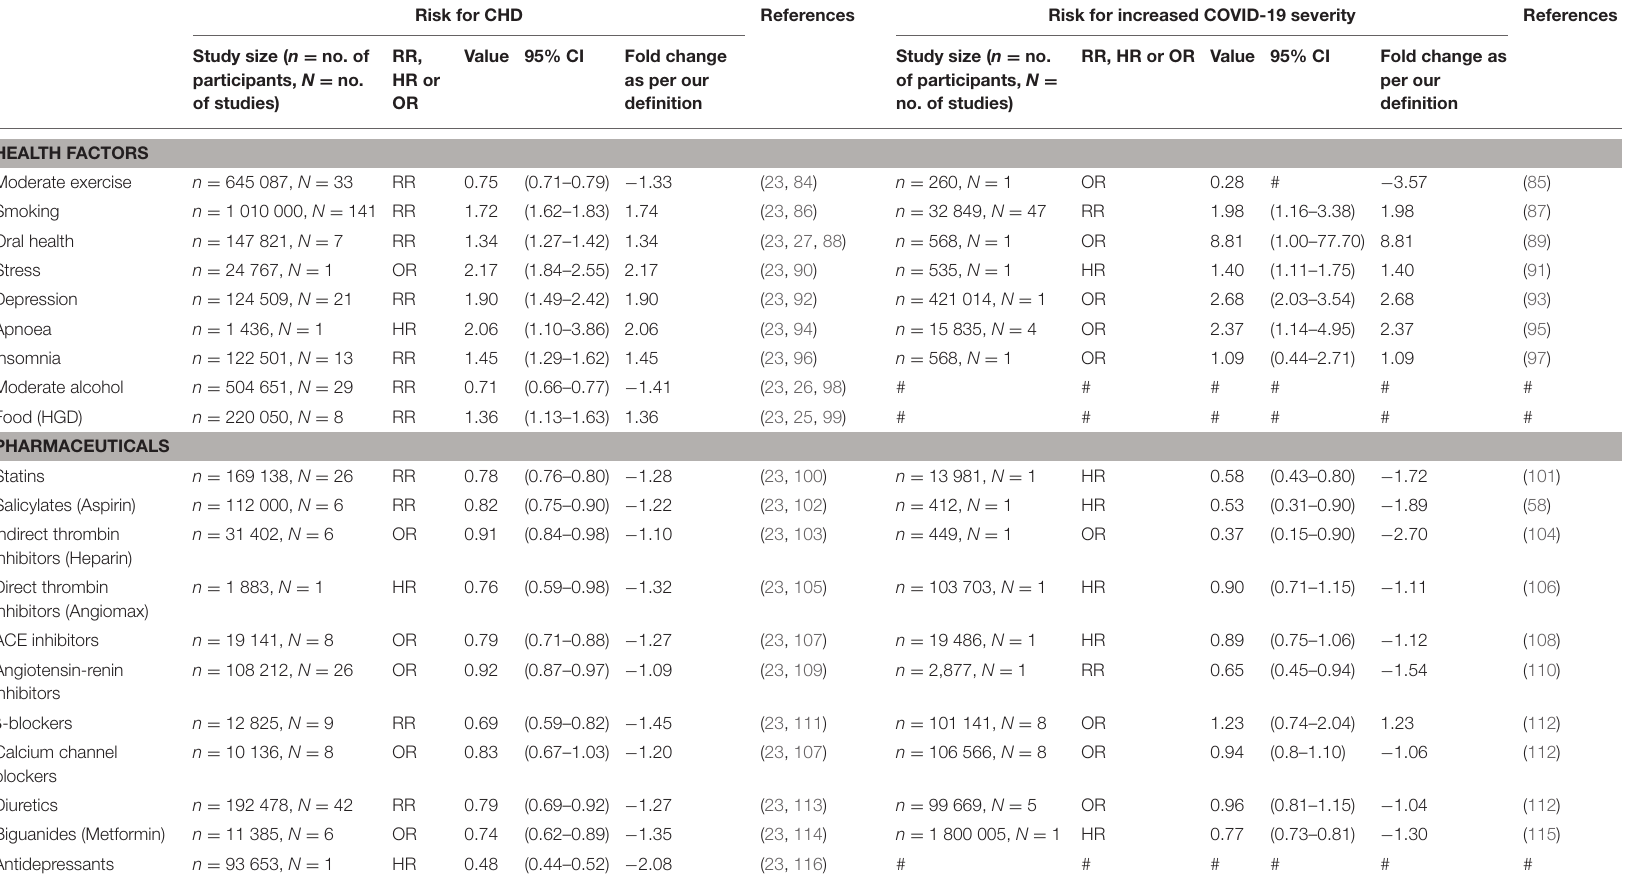
TABLE 2 | The effect which different health factors and pharmaceuticals have on CHD risk and Covid-19